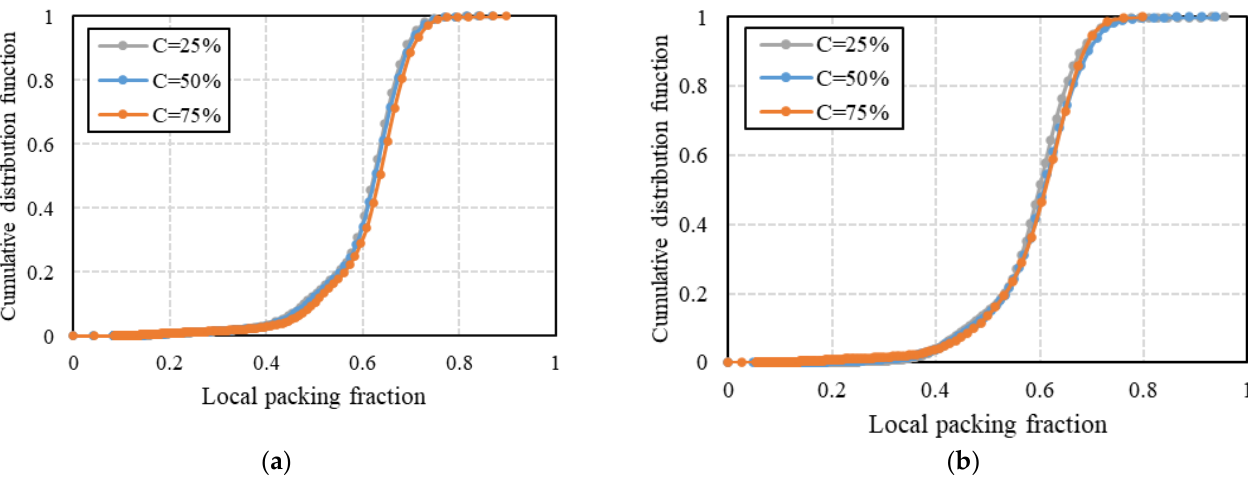
Figure 8. Cumulative distributions of local packing fractions of ( a ) binary mixtures of AR = 1 and AR = 2 and ( b ) binary mixtures of AR = 1 and AR = 3.